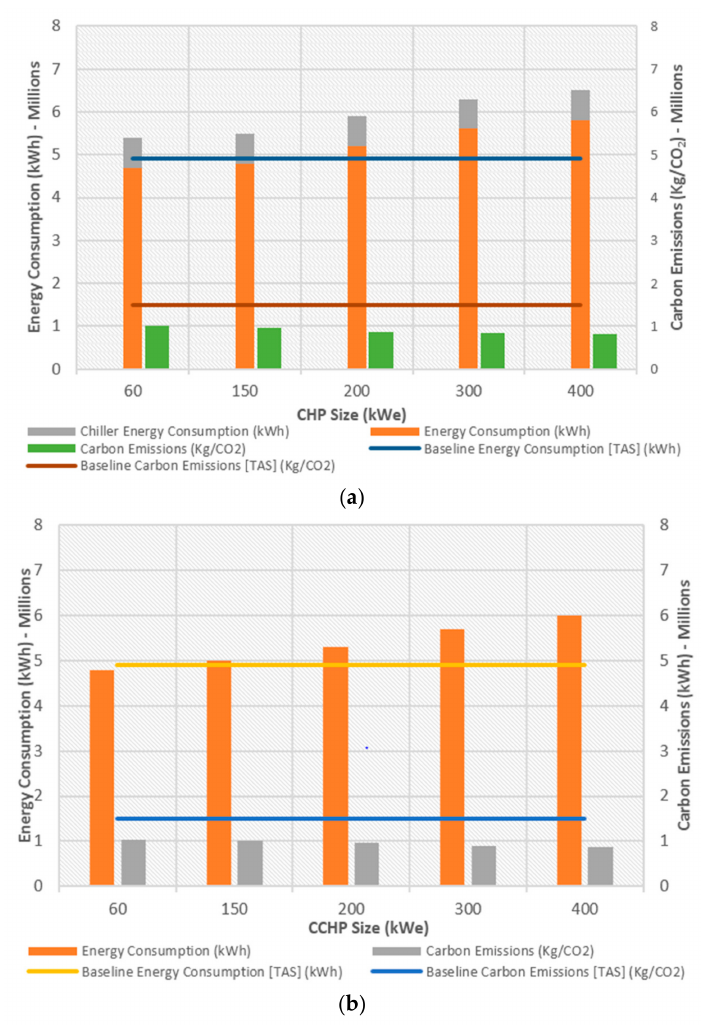
Figure 5. ( a ) Comparison of the performance of various sized CHP and ( b ) CCHP systems in terms of energy consumption and